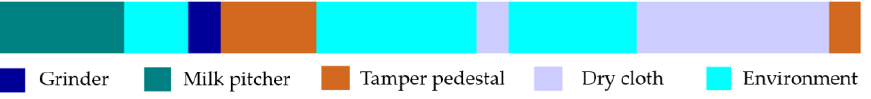
Figure 14. Example of visualization based on eye fixations: Terminology education, step 6 (“Find the tamper pedestal and touch it with your hands), pass.